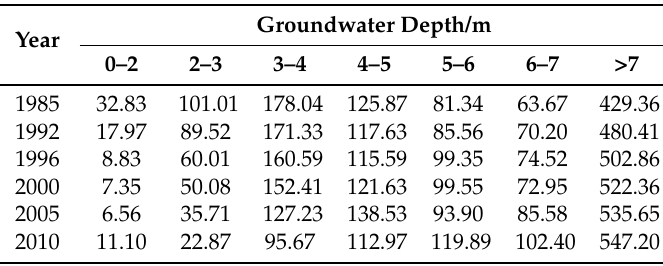
Table 5. The area transition matrix with different ranges of groundwater depth (km 2 ).